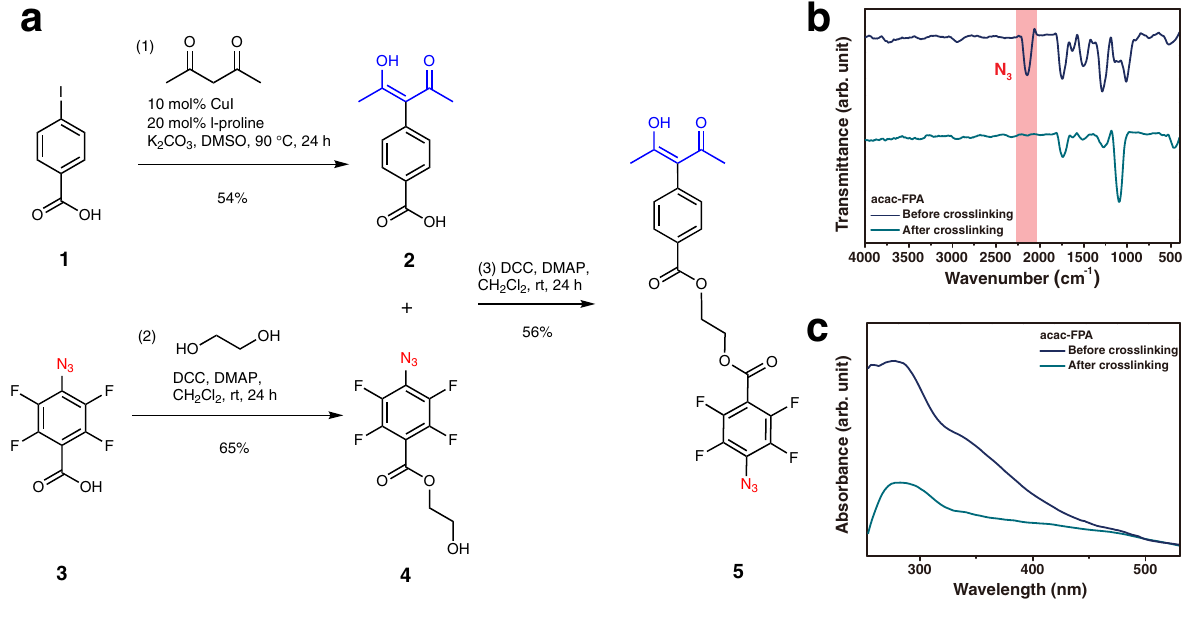
Fig. 2 | Synthetic scheme and characterization of acac-FPA as a chelating ligand. a Synthetic procedure for acac-FPA. b FT-IR spectra of acac-FPA fi lms beforeandafterbeingcross-linked.Theredshaderepresentsthepresenceofazide